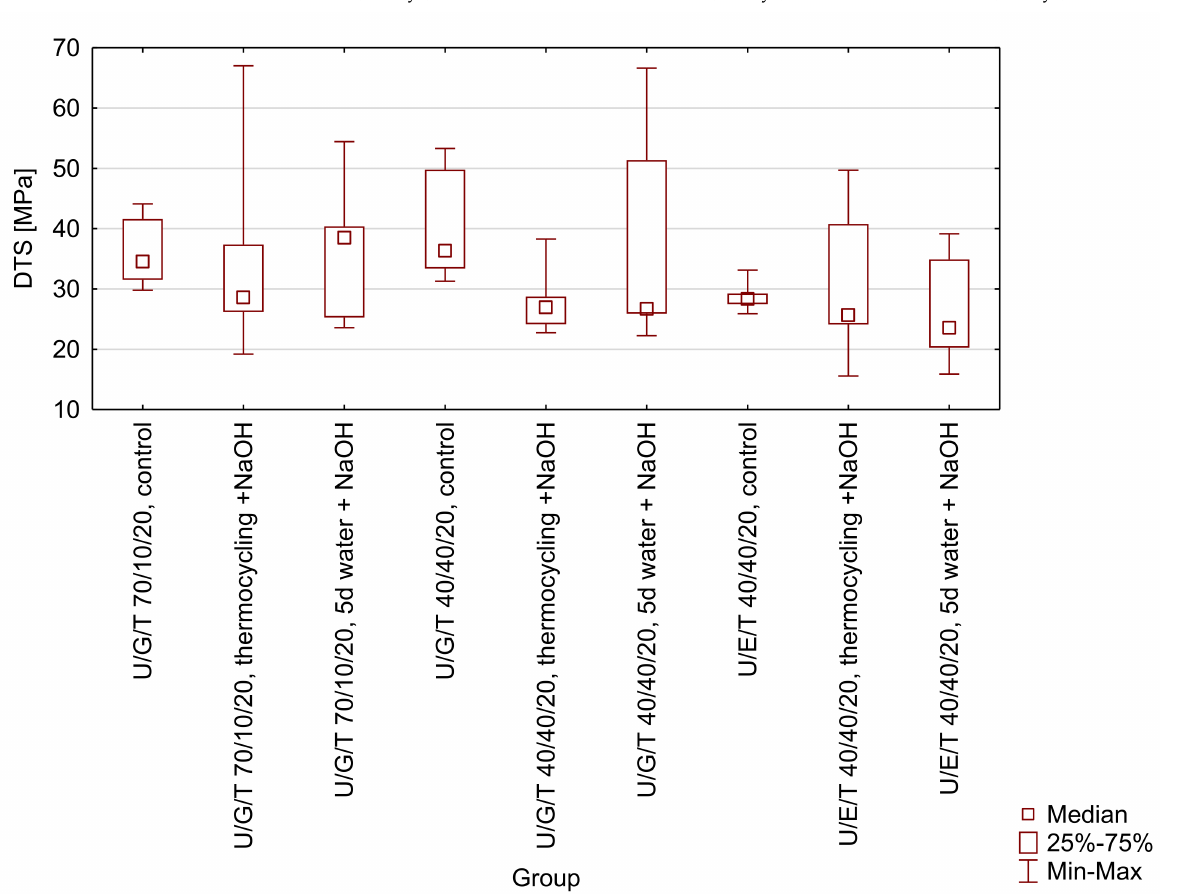
Figure A2. Box-and-whisker plot of diametral tensile strength (DTS) of tested matrices (UDMA/Bis-GMA/TEGDMA 70/10/20 wt.% and 40/40/20 wt.% and UDMA/Bis-EMA/TEGDMA 40/40/20 wt.%) after selected ageing protocols (control-water, 24 h, 37 ◦ C; thermocycling + NaOH- water, 7500 thermo cycles, 5/55 ◦ C and 0.1 M NaOH, 7 days, 60 ◦ C; 5d water + NaOH-water, 5 days, 55 ◦ C and 0.1 M NaOH, 7 days). No significant differences were